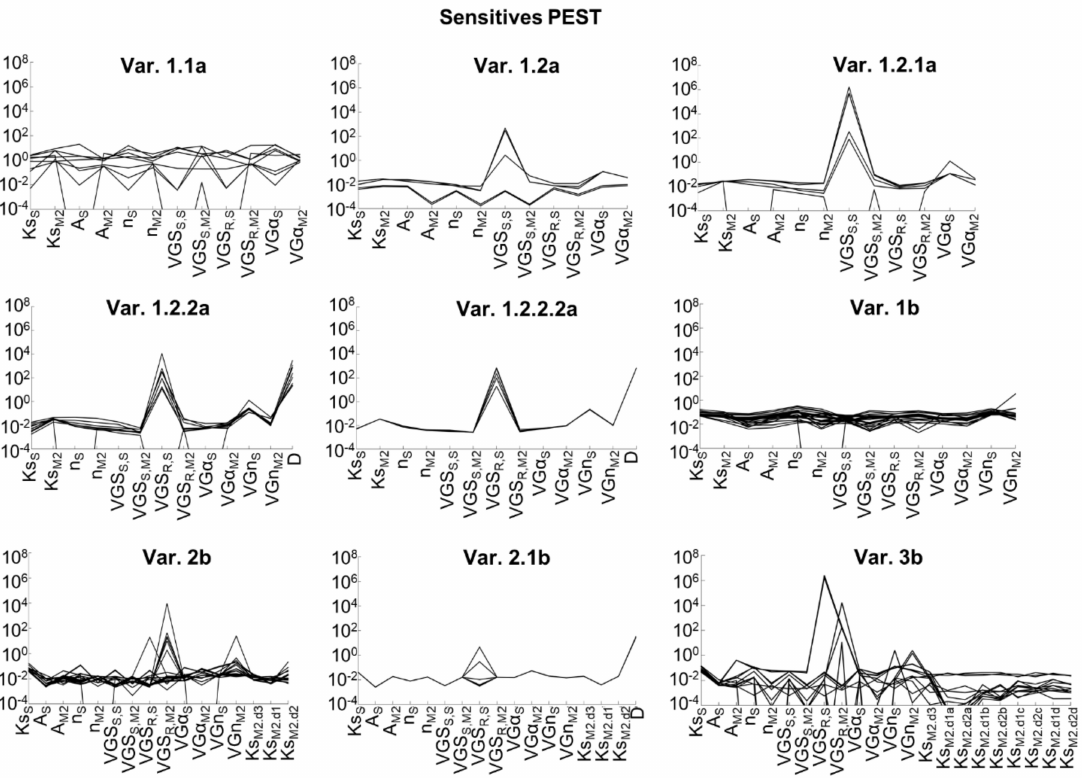
Figure 15. Sensitives per iteration step for selected PEST